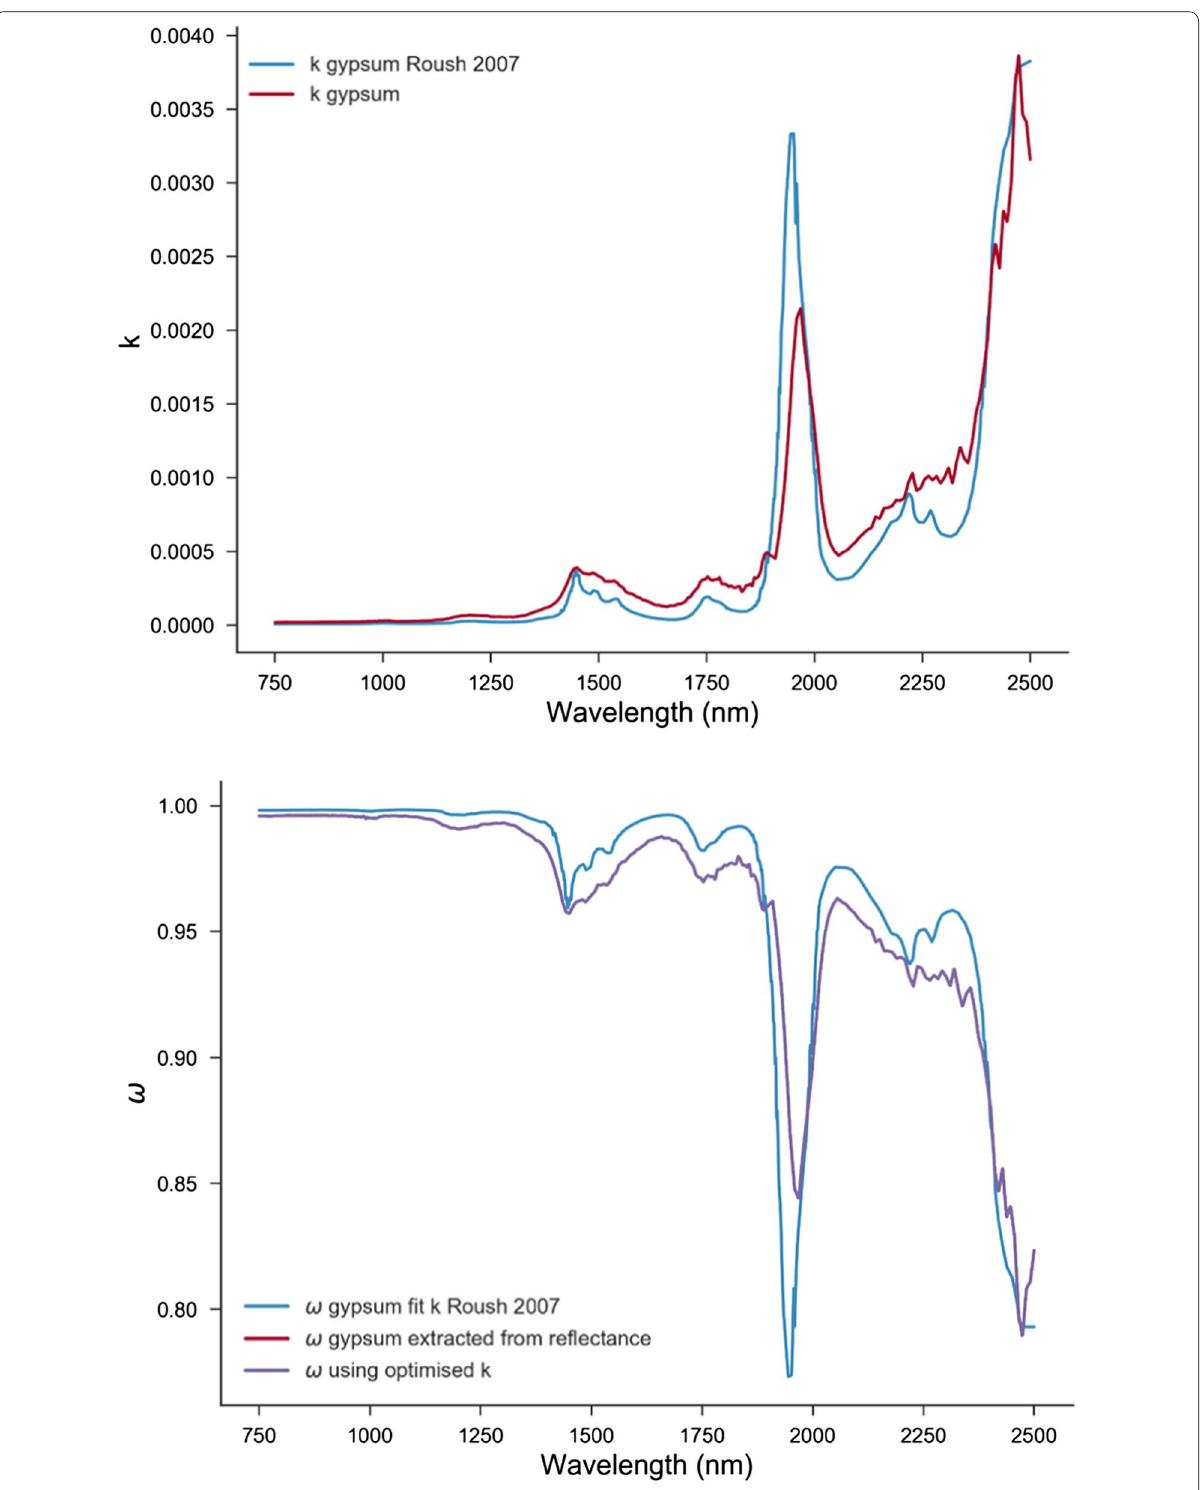
Fig. 6 Comparison between the obtained values of k and ω with those reported in the